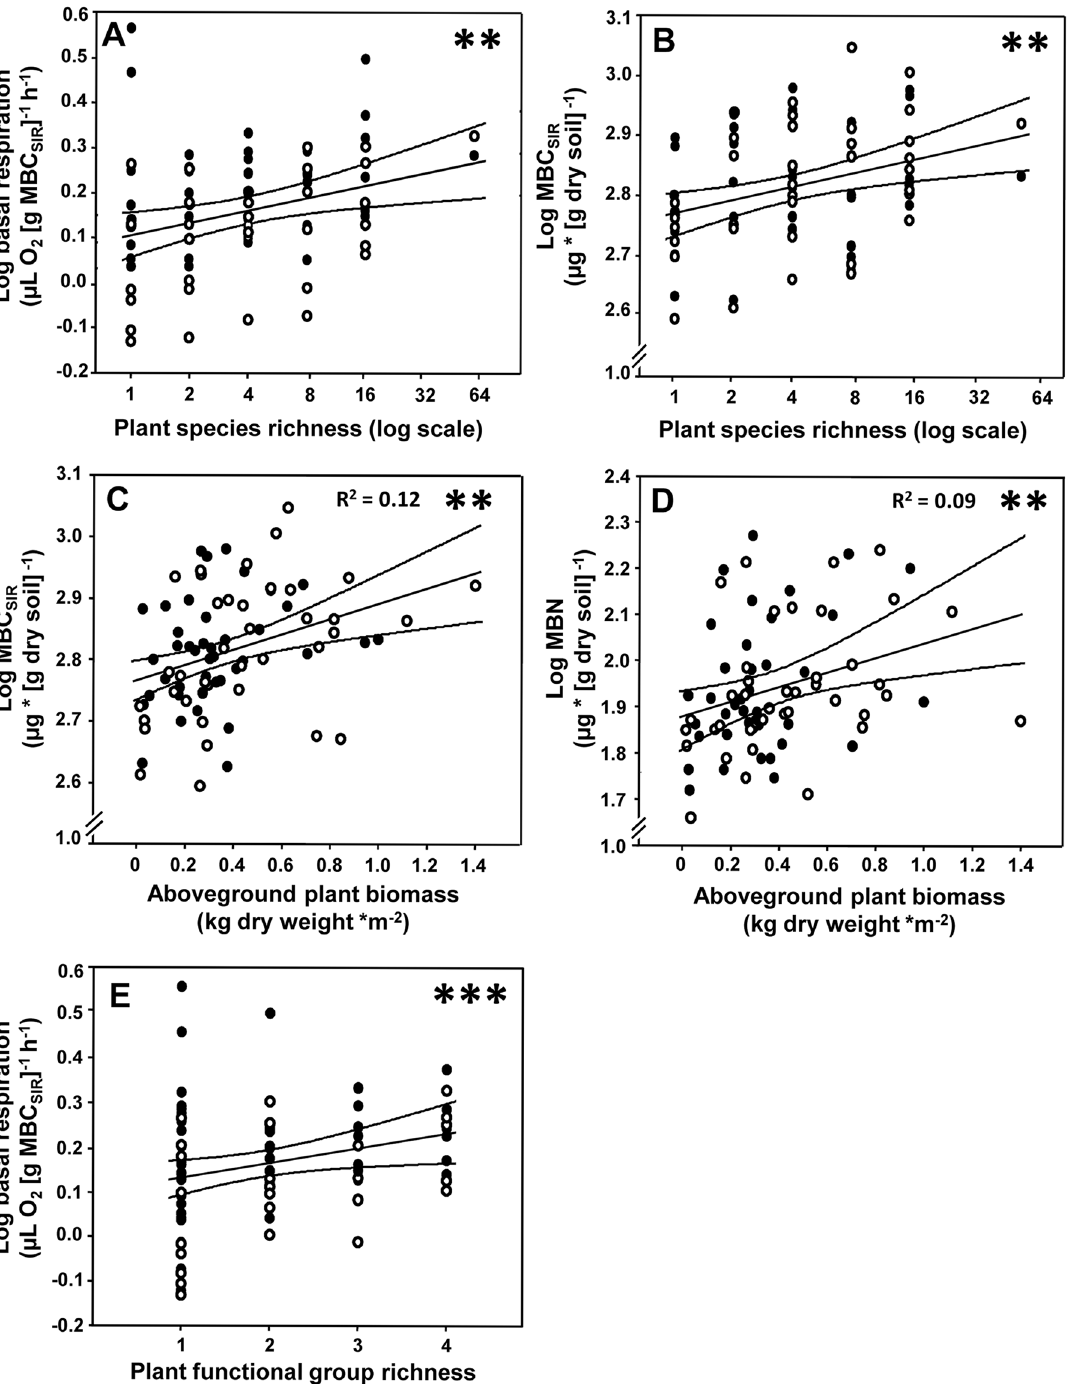
Fig 1. Effects of plant diversity and shoot biomass on microbial basal respiration and soil microbial biomass C and N. Effects of plant species richness on (A) basal respiration and (B) soil microbial biomass C. (C) Relationships between aboveground plant biomass (dry weight) and soil microbial biomass C, and (D) between aboveground plant biomass and soil microbial biomass N. (E) Effects of plant functional group richness on basal respiration. Note log scale of y-axes. Black dots are measures from unfertilized plots, white dots from fertilized plots. Regression lines with 95% confidence bands. Asterisks indicate significant differences ( ** p (cid:1) 0.01, *** p (cid:1) 0.001).